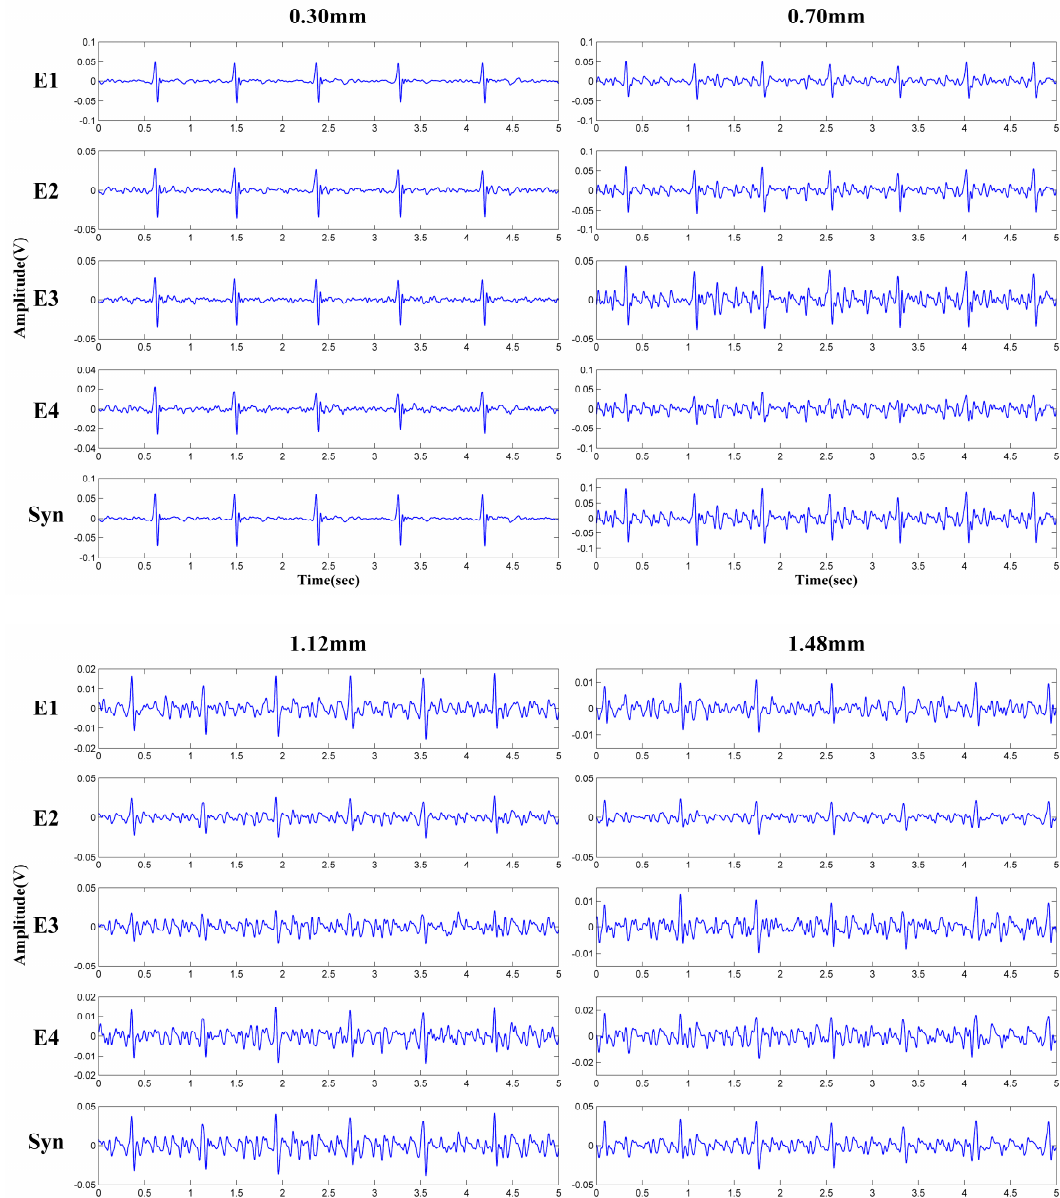
Figure 11. ECG signals under different clothing thickness.